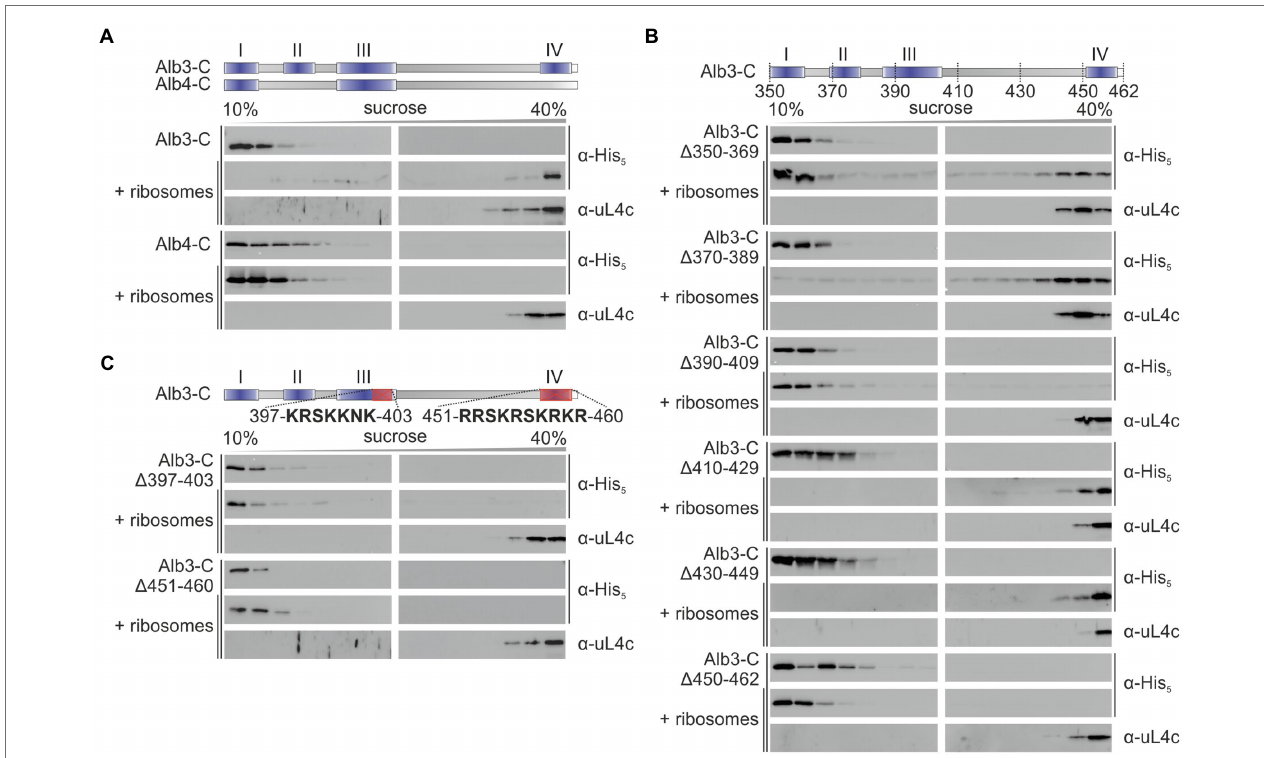
FIGURE 2 | Sucrose gradient interaction assay of recombinant Alb3 and Alb4 C-terminus variants with chloroplast ribosomes. The recombinant His-tagged C-terminal regions of Alb3 and Alb4 and the indicated deletion constructs were incubated with chloroplast ribosomes and loaded onto a sucrose density gradient. After ultracentrifugation, the gradient fractions were analyzed immunologically using antibodies against the His-tag ( α -His) and the chloroplast ribosomal protein uL4c ( α -uL4c). Sucrose density gradient centrifugation of the recombinant proteins in the absence of ribosomes was used as negative control. Alb3-C, C-terminal region of Alb3 (amino acids 350–462); Alb4-C, C-terminal region of Alb4 (amino acids 334–499). (A) Comparison of Alb3-C and Alb4-C. (B) A successive experimental series of 20 amino acid deletions introduced into the Alb3-C construct. (C) Targeted deletions of highly conserved arginine- and lysine-rich sequences within motif III and motif